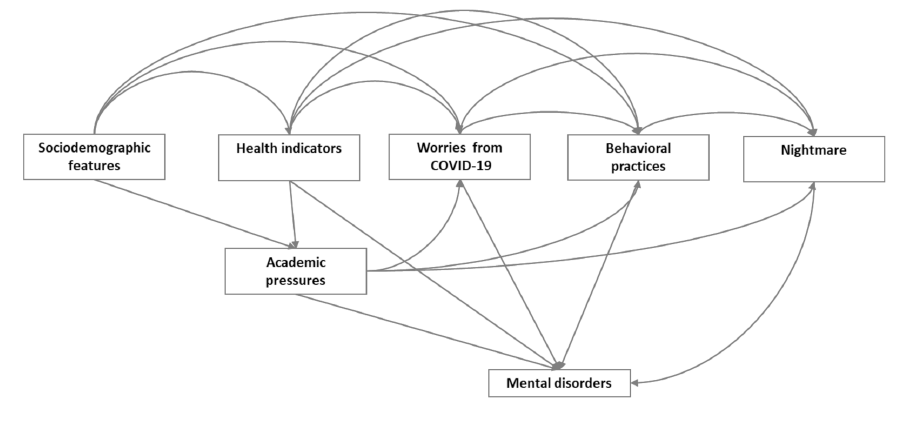
Figure 1. Directed acyclic graph used in building the regression model adjustment and testing the study hypothesis. The squares represent the study’s variables, and the arrows represent the direction of the relationship between the study’s